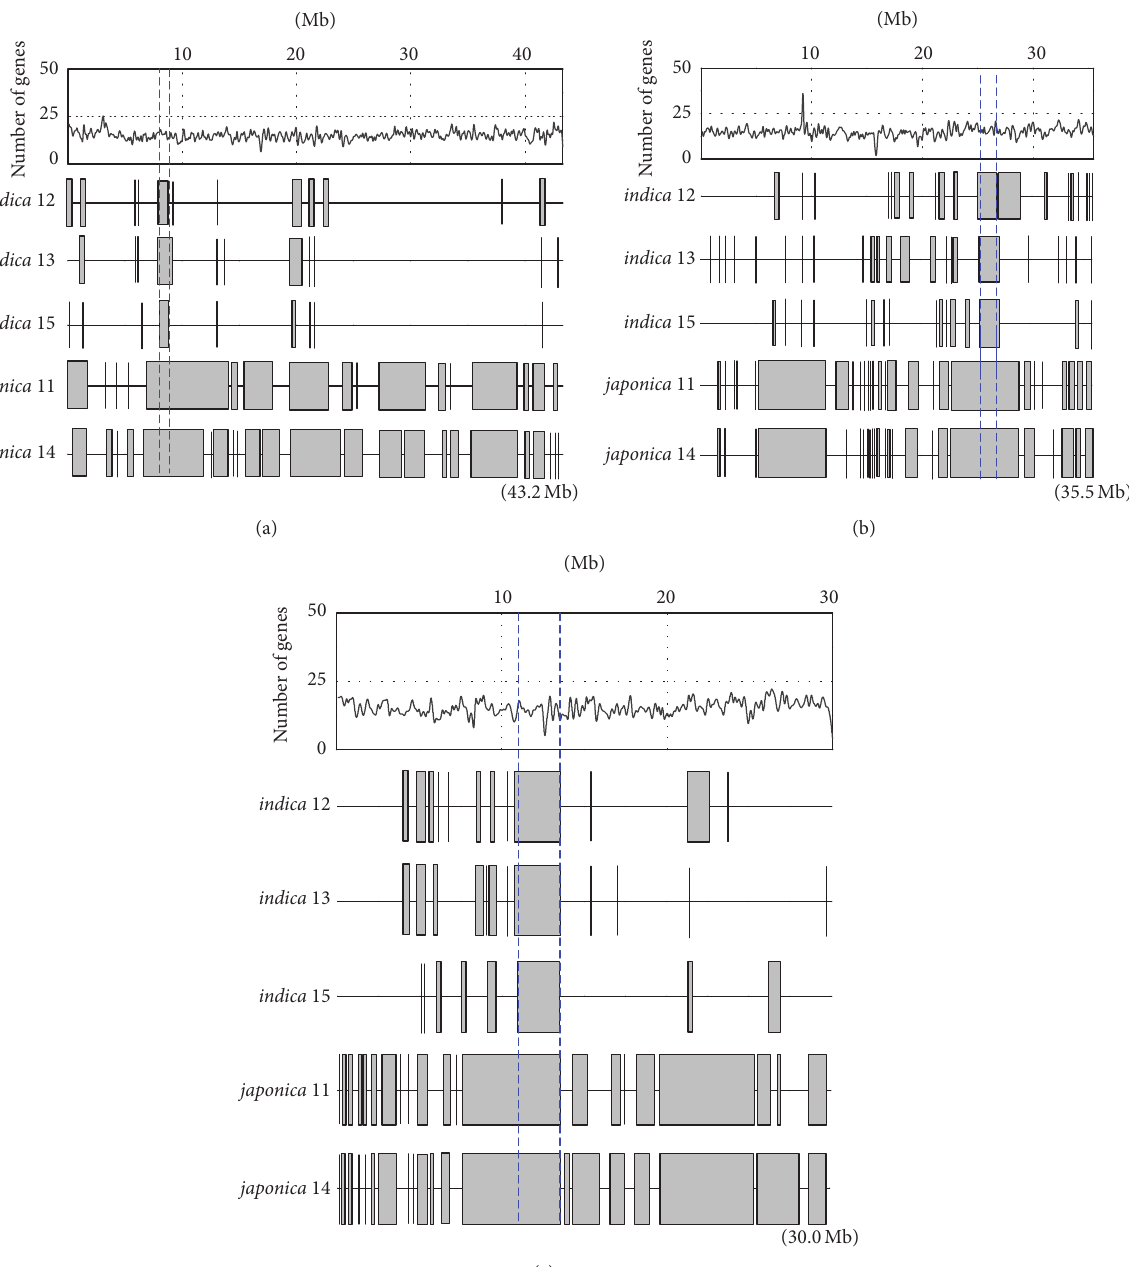
Figure 3: Distribution of “SNP deserts” on (a) chromosome 1, (b) chromosome 4, and (c) chromosome 5 in the five landraces. The low-SNP density regions are shown as gray bars or vertical lines. The vertical-dash intervals indicate the “SNP deserts” occurring in all five landraces. The line charts represent the distribution of genes across the chromosomes. The chromosome sizes are indicated in